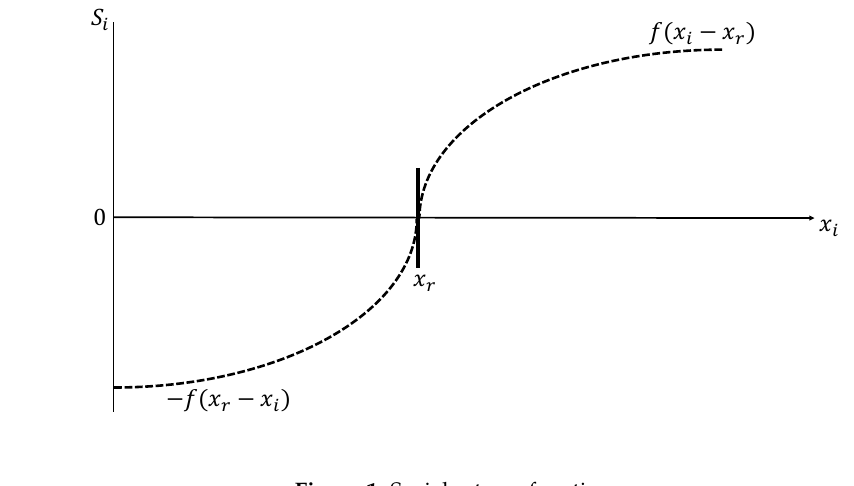
Figure 1. Social esteem